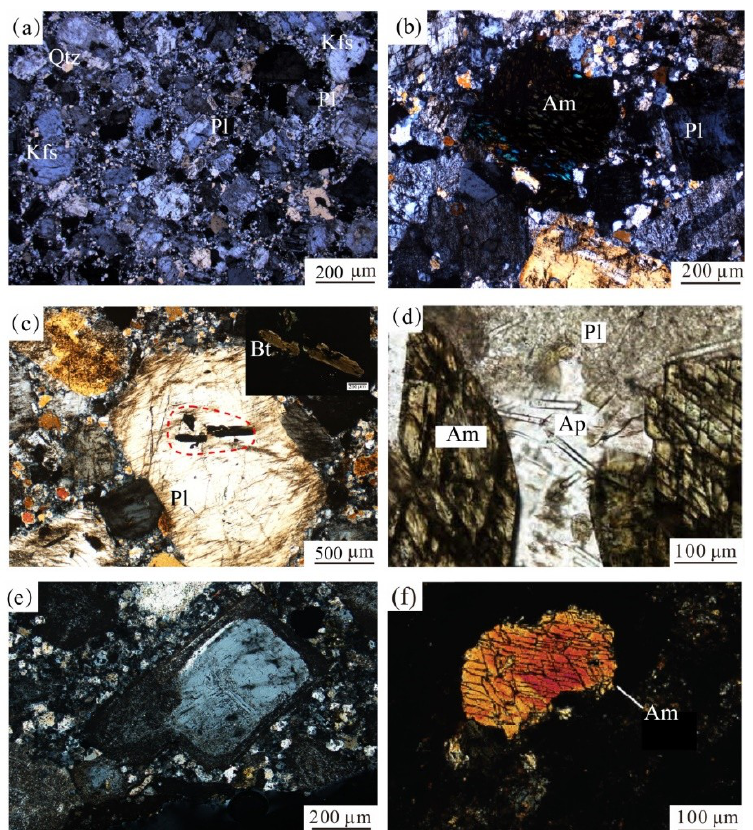
Figure 3. Photomicrographs of the monzogranite porphyries at the Wandongshan and Bailiancun districtdistricts. ( a ) The monzogranite porphyries at the Wandongshan deposit; cross-polarized light; ( b ) Plagioclase and amphibole phenocrysts of the Wandongshan monzogranite porphyries; cross-polarized light; ( c ) Biotite is inside the plagioclase; cross-polarized light; ( d ) Dioritic enclaves from Wangdongshan; cross-polarized light [23]; ( e , f ) are photographs of monzogranite porphyries at the Bailiancun district; cross-polarized light. Qtz: quartz; Kfs: K-feldspar; Pl: plagioclase; Bt: biotite; Am: amphibole; Ap: apatite.